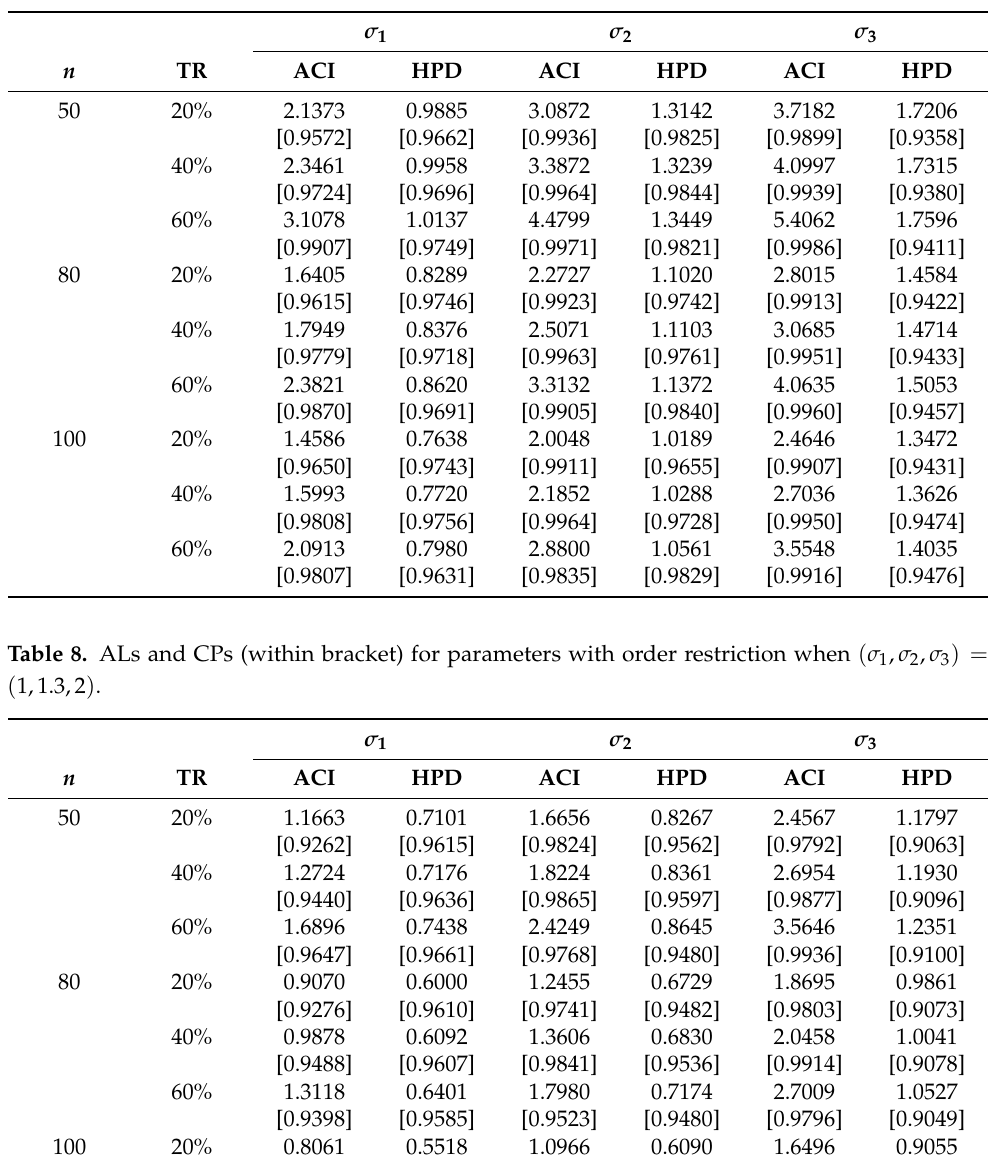
Table 7. ALs and CPs (within bracket) for parameters with order restriction when ( σ 1 , σ 2 , σ 3 ) = ( 1.5,2,2.5 ) .